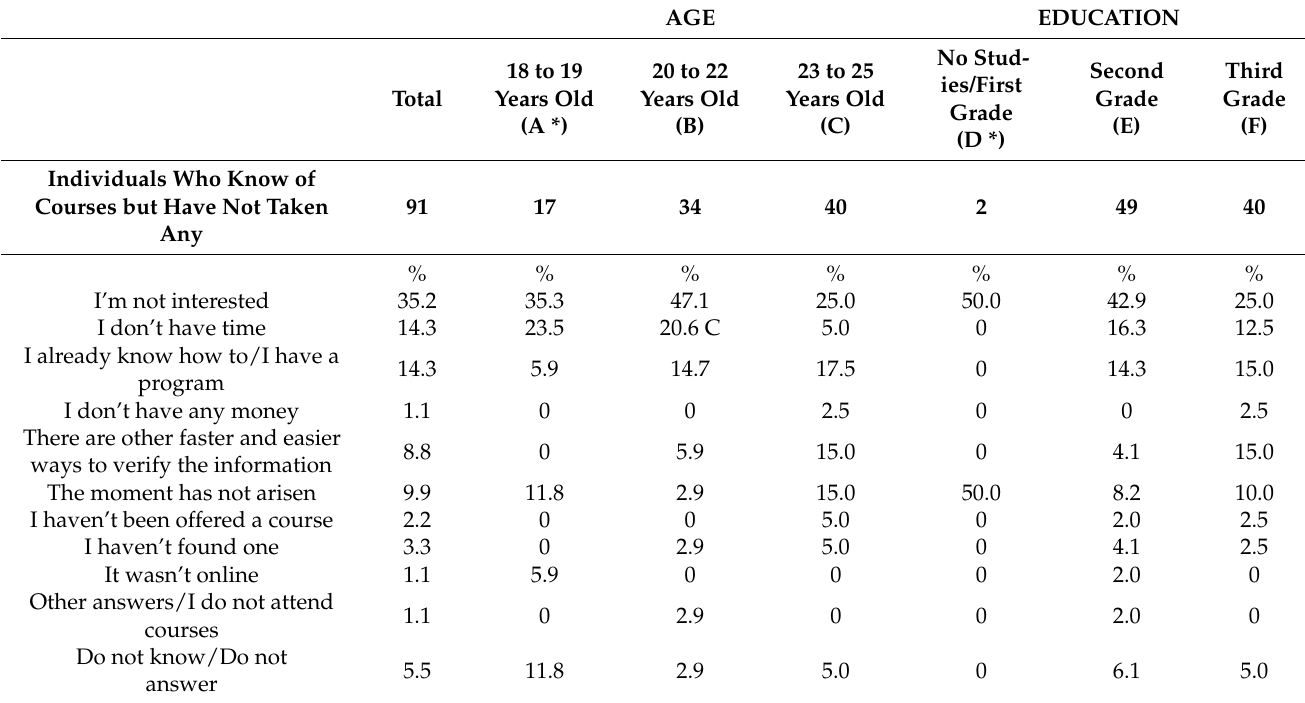
Table 7. Question 20: Why have you not taken any course or training on how to detect fake news? (Do not